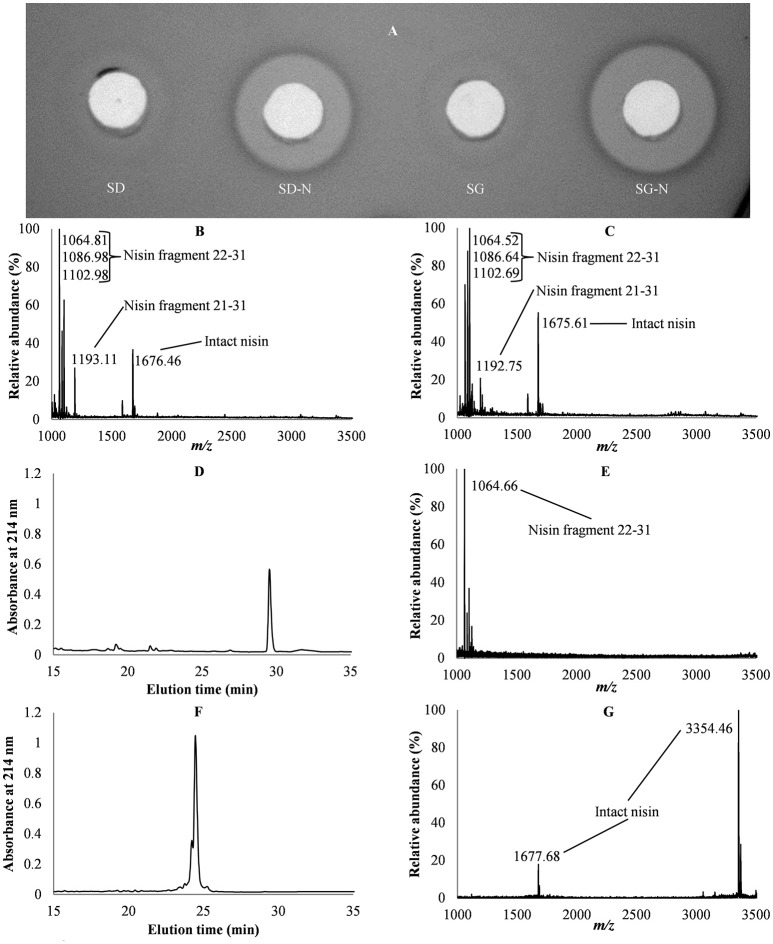
Analysis of fecal pellets of mice consuming starch dough (SD), starch dough containing nisin (SD-N), starch gel (SG), and starch gel containing nisin (SG-N) diets. Activity assay of fecal pellets of mice consuming SD, SD-N, SG, and SG-N diets (A). Mass spectroscopy of fecal pellets from mice consuming SD-N (B) and SG-N diets (C). RP-HPLC chromatogram of fecal pellets from mice consuming SG-N (D) and mass spectroscopy of the elution peak (E). RP-HPLC chromatogram of intact nisin (F) and mass spectroscopy of the elution peak (G).